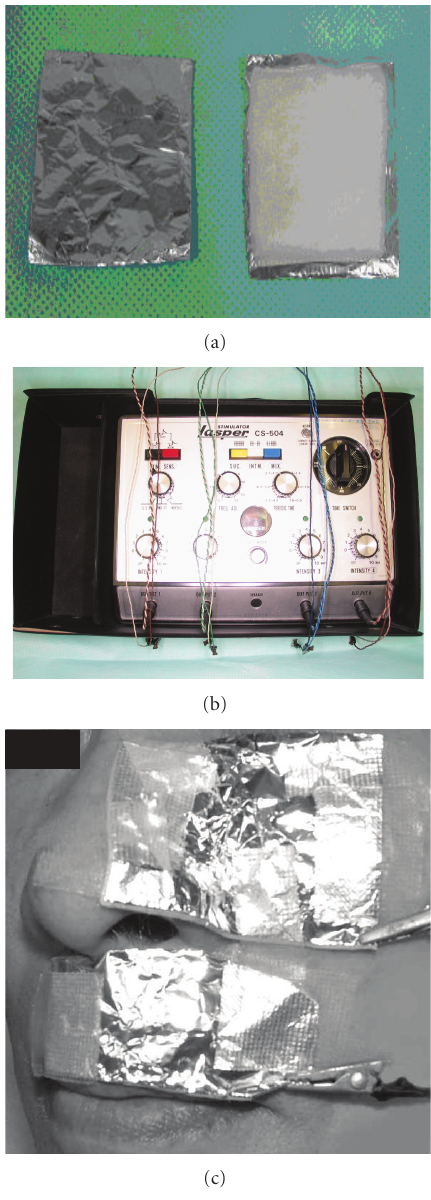
Figure 1: The electrodes were made of cotton and aluminum foil (a). A pulsed alternating current (AC) voltage generator was used (LASPER; Sankyo Electric Co., Japan) (b). A photograph of application to a patient